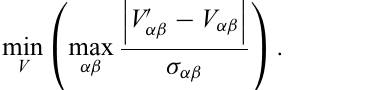
FIG. 13. Two-mode quadrature histograms without subtrac- tion. The histogram obtained with the pump on is shown in (a), while (b) shows the reference histogram measured with the pump